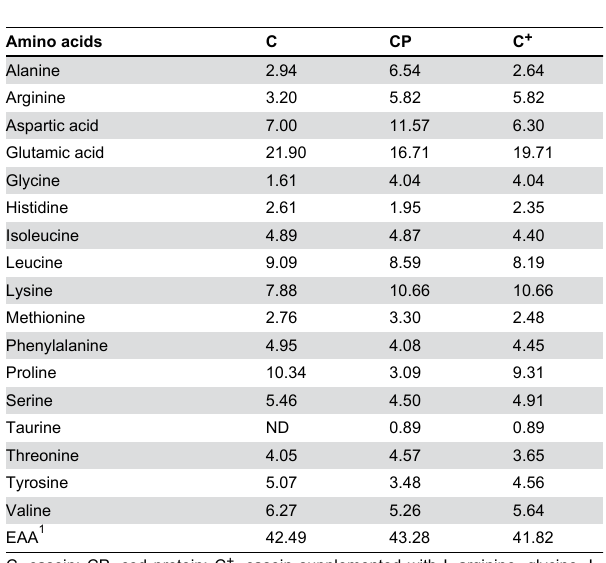
Table 1. Amino acid composition of dietary protein sources (g/100 g of amino